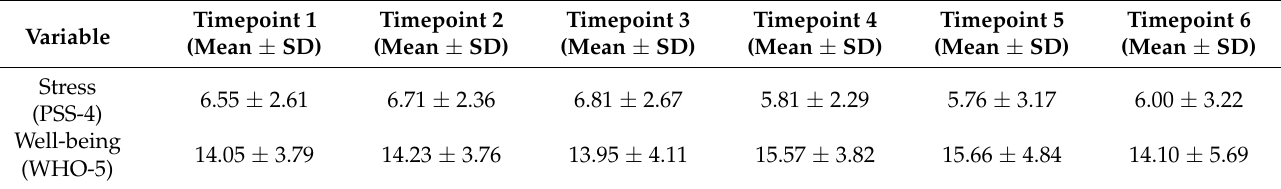
Table 3. Descriptive statistics for stress and well-being at each timepoint.